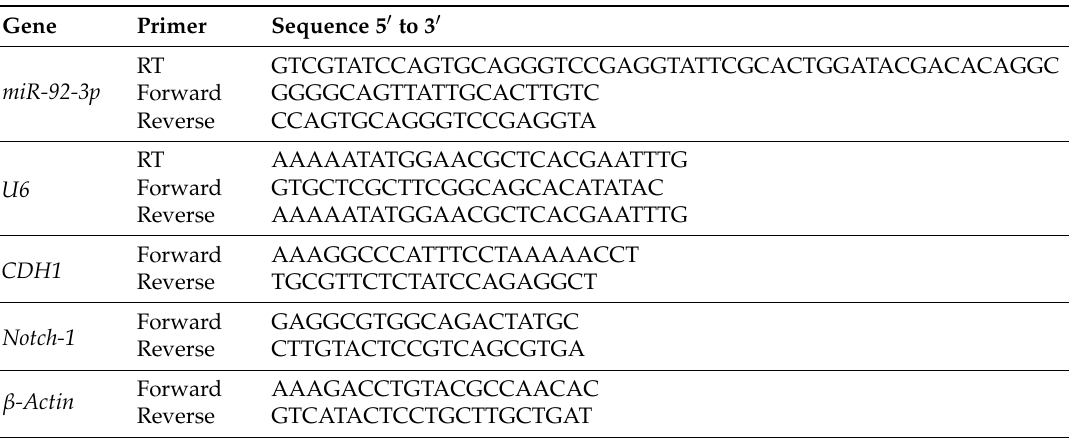
Table 2. Primers used for